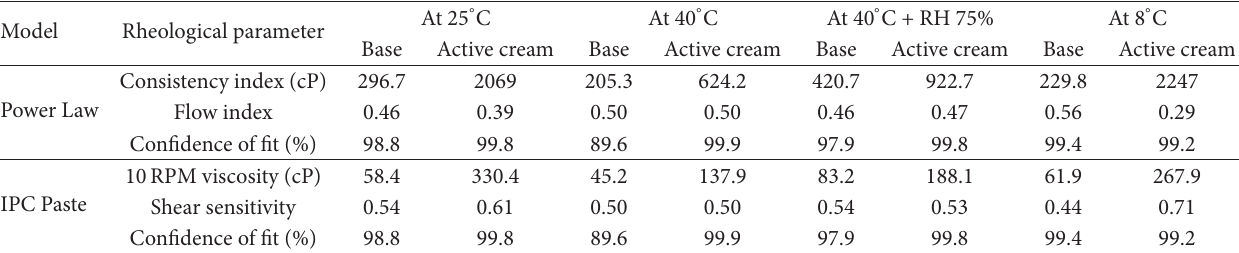
T 4: Rheological parameters at eight weeks of base and active cream kept at 25